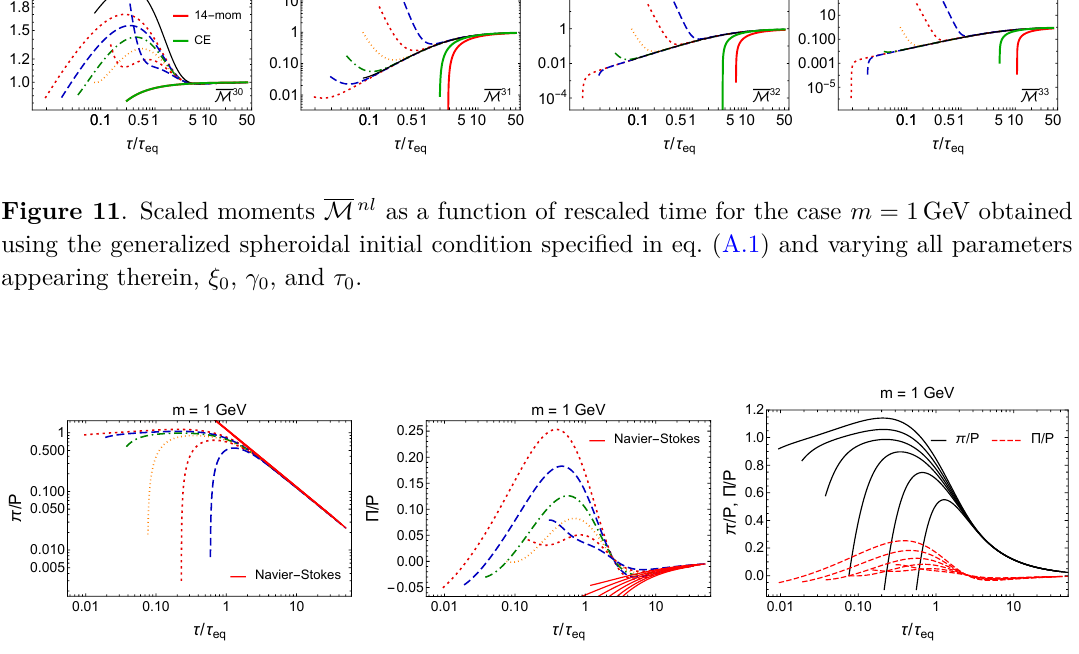
Figure 12 . Scaled shear viscous correction π/P (left), bulk viscous correction Π /P (middle), and both combined (right) as a function of rescaled time τ/τ eq for m = 1 GeV and varying all parameters appearing in eq. (A.1), ξ 0 , γ 0 , and τ 0 , while holding the initial energy density fixed to that of an isotropic equilibrium gas with T 0 = 1